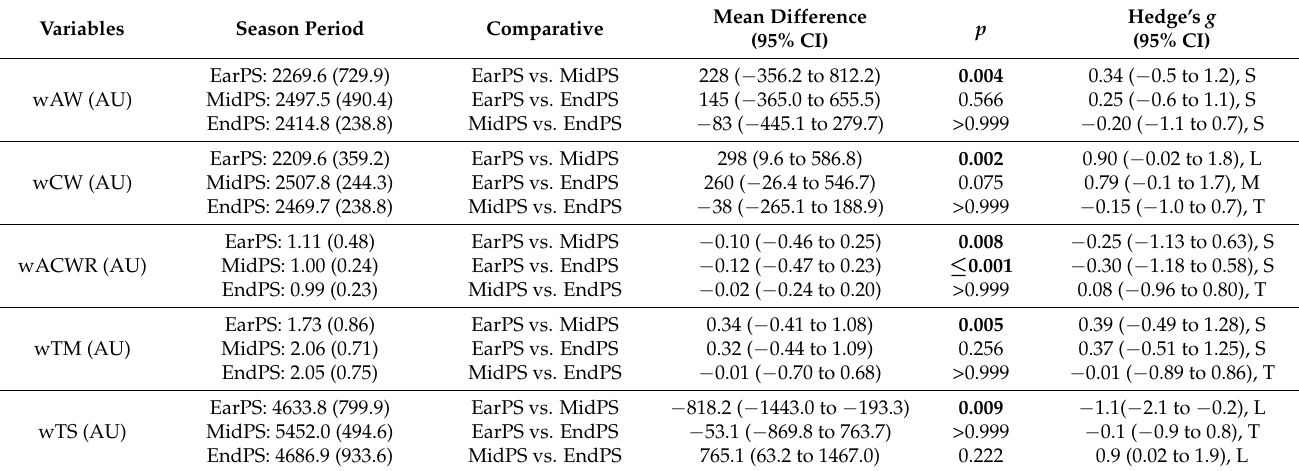
Table 6. Comparison of workload variables between preparation season